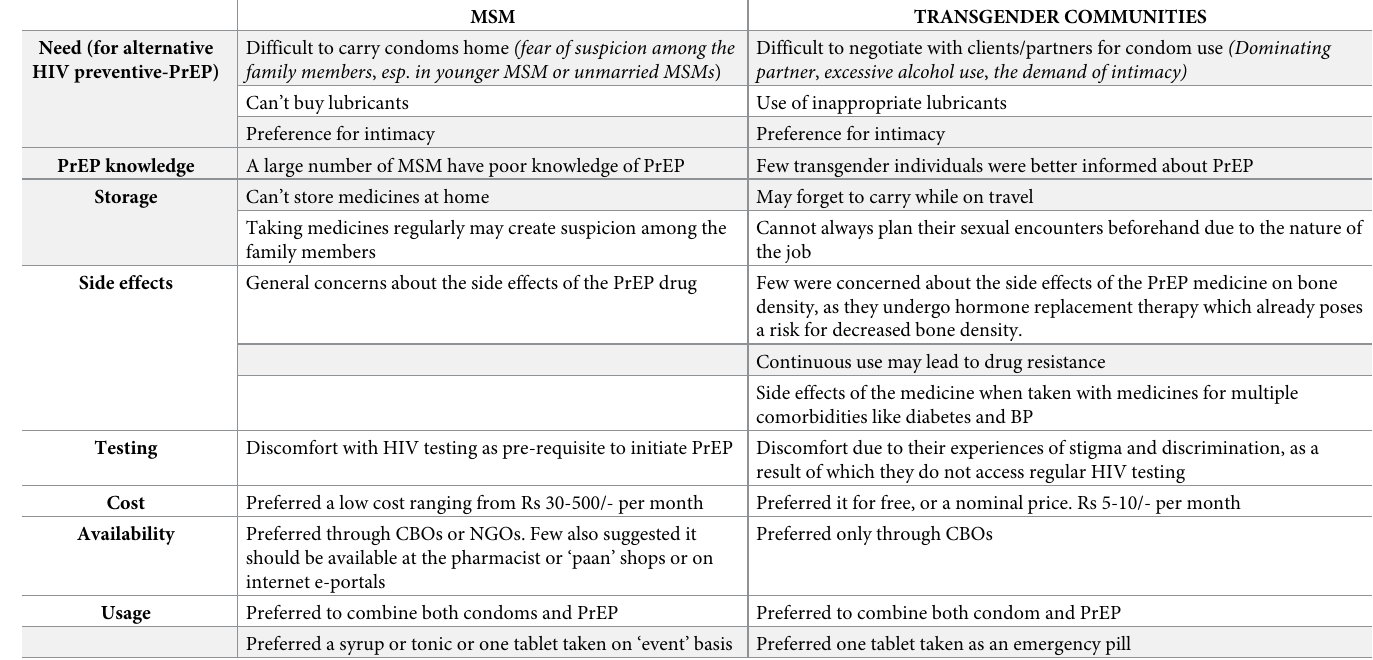
Table 2. Comparison between perspectives of MSM and transgender communities on PrEP